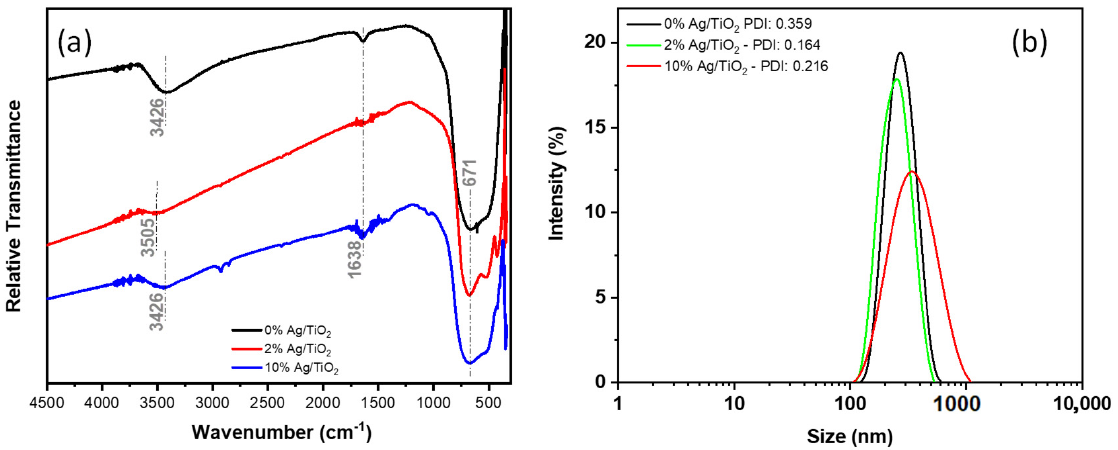
Figure 2. ( a ) FTIR spectrum of samples 0% Ag/TiO 2 (curve in black), 2% Ag/TiO 2 (curve in red), and 10% Ag/TiO 2 (curve in blue) and ( b ) hydrodynamic radius of dispersion of mixed oxides in water—0% Ag/TiO 2 (curve in black), 2% Ag/TiO 2 (curve in green), and 10% Ag/TiO 2 (curve in red).